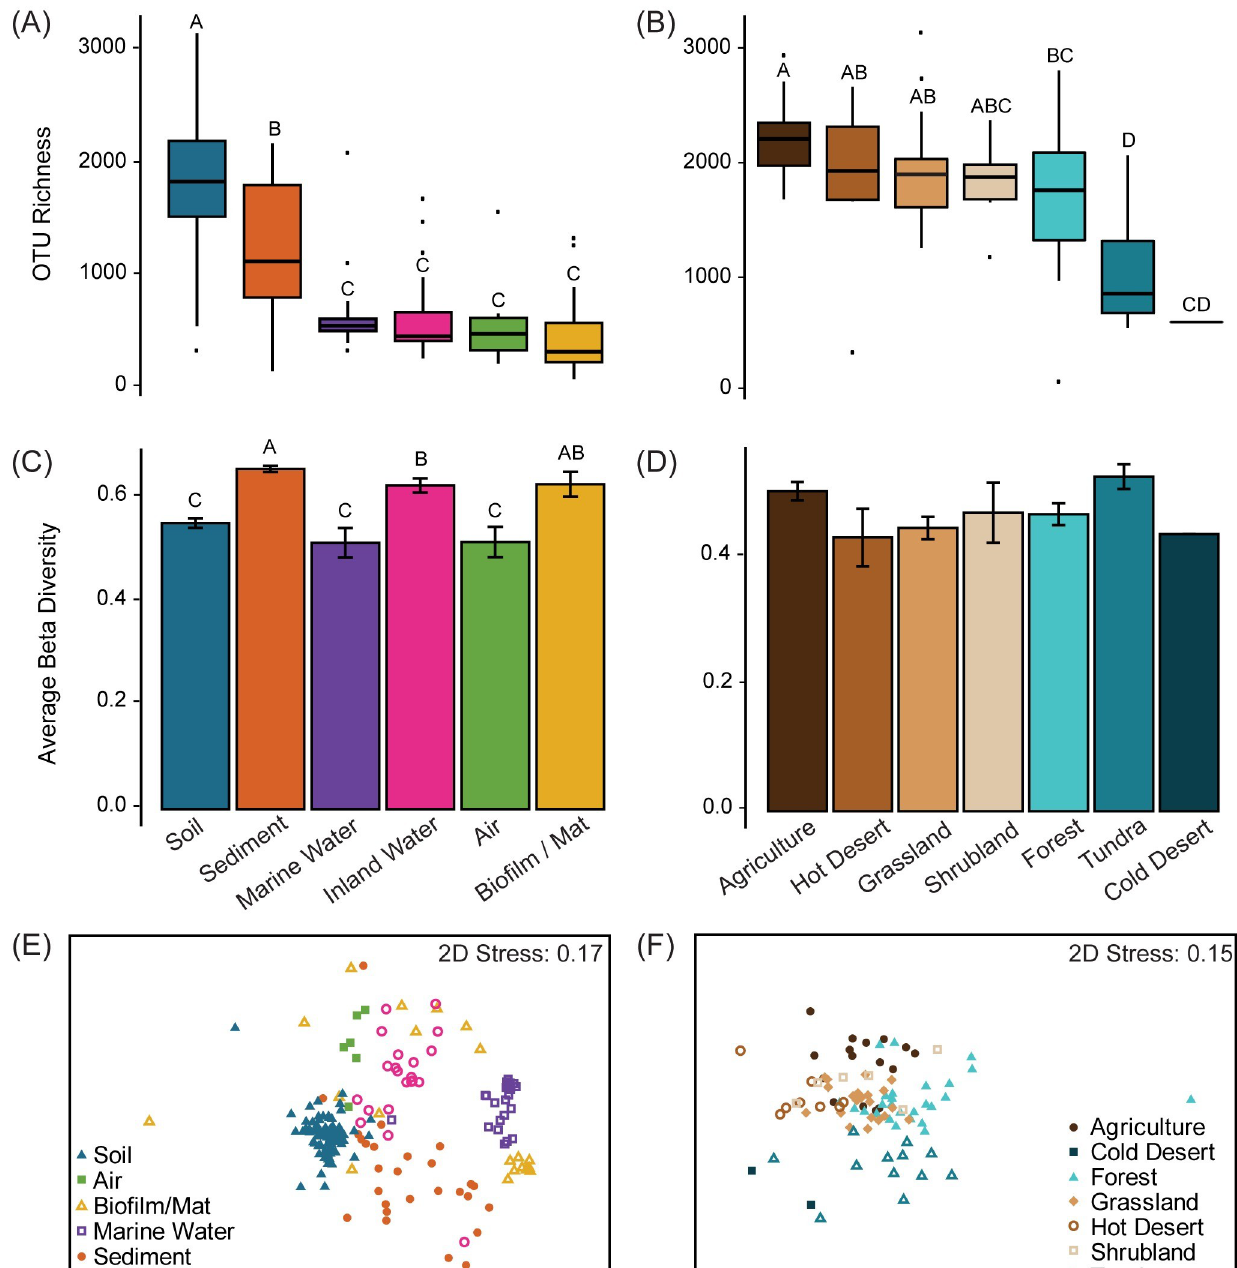
Fig 2. Alpha- and beta-diversity patterns. Alpha- and beta-diversity per habitat for all geoclusters used in study (A, C, and E) and per biome for soil geoclusters (B, D, and F). (A and B) Boxplot of alpha-diversity (OTU richness). (C and D) Mean beta-diversity (distance from centroid) ± standard error. For all bar and boxplots, letters above indicate significant differences among groups (Tukey test) where groups that share a letter are not significantly different from each other. (E and F) NMDS of